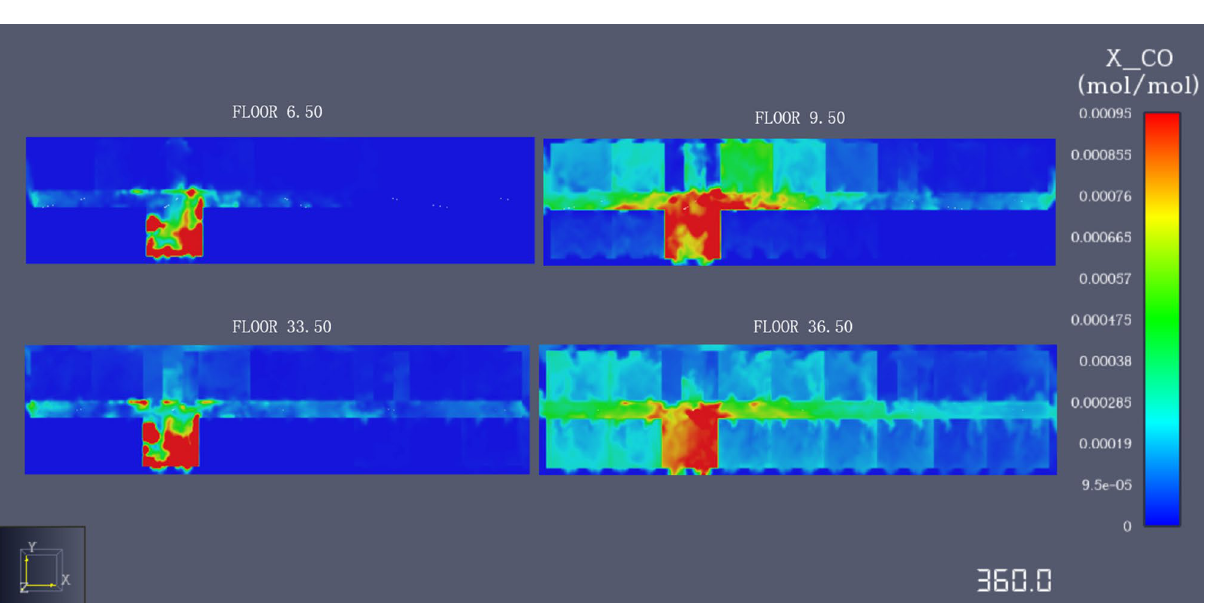
Figure 10. Section diagram of CO concentration